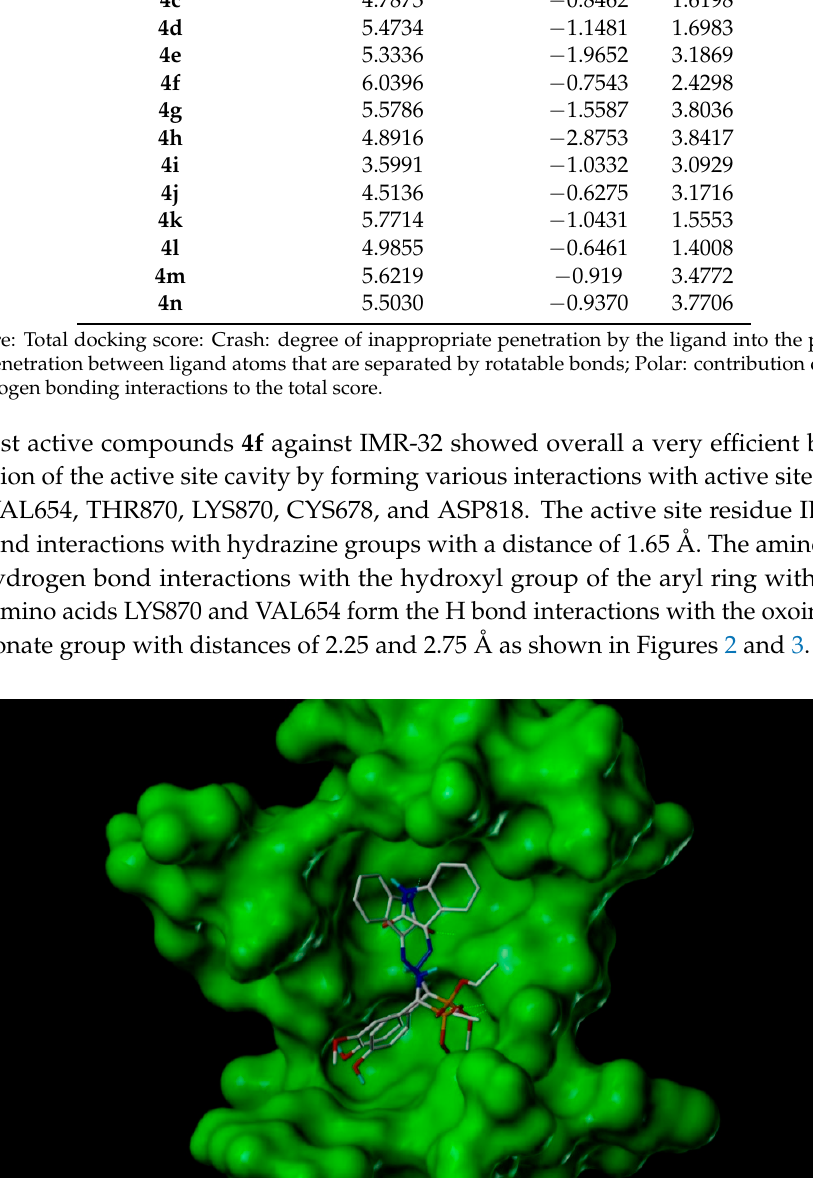
Figure 2 . 3D representation of binding modes of most active forms of methylphosphonate derivatives 4f and 4g in the putative active site of TRKs enzyme.